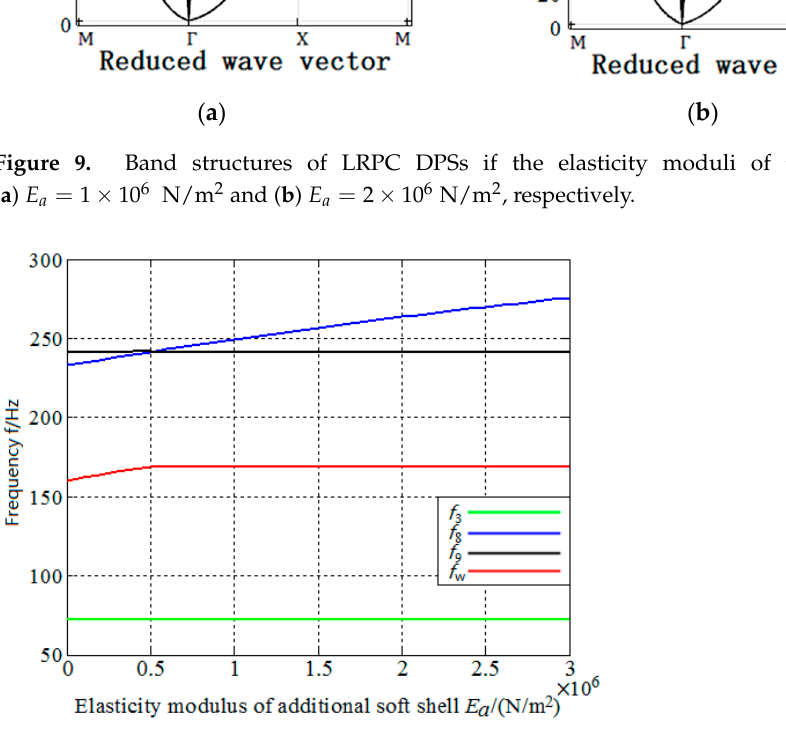
Figure 10. The influences of elasticity moduli of soft shell E a on critical frequencies f 3 , f 8 , f 9 , and band gap width f w